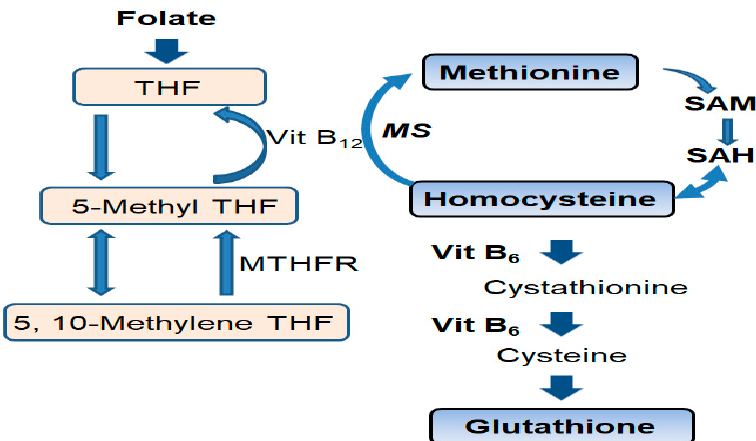
Figure 1. Homocysteine (Hcy) metabolic pathway. Folate and vitamin B 12 are cofactors in the one carbon metabolism, during which they promote the remethylation of homocysteine. Vitamin B 12 and folate deficiency inhibits the metabolism from Hcy to methionine, and causes hyperhomocysteinemia (HHCy). Vitamin B 6 deficiency also inhibits the conversion of Hcy to cystathionine and causes hyperhomocysteinemia. SAM: S-adenosylmethionine; SAH: S-adenosylhomocysteine; Hcy: homocysteine; Vit B 6 : vitamin B 6 , Vit B 12 : vitamin B 12 ; THF: tetrahydrofolate; 5-Methyl THF: 5-methyltetrahydrofolate; MTHFR: 5, 10-methylenetetrahydrofolate reductase; MS: methionine synthase.